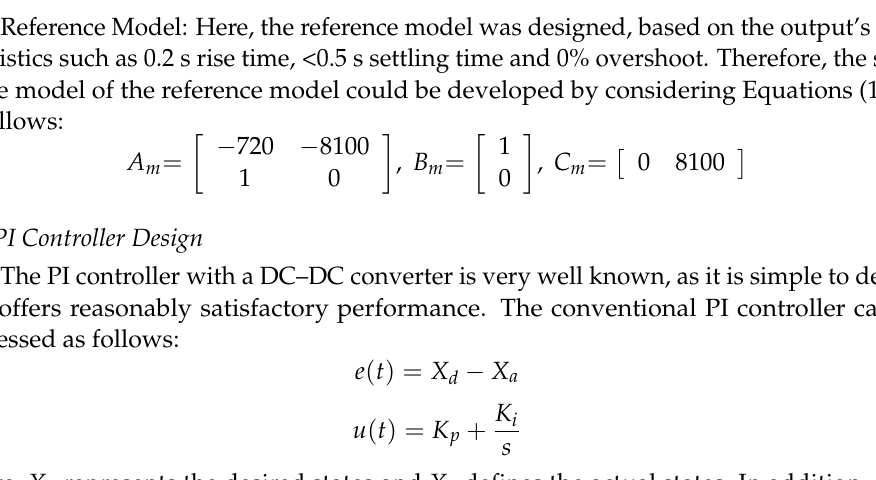
Figure 3. A block diagram of a DC–DC converter (i.e., buck–boost converter) with a